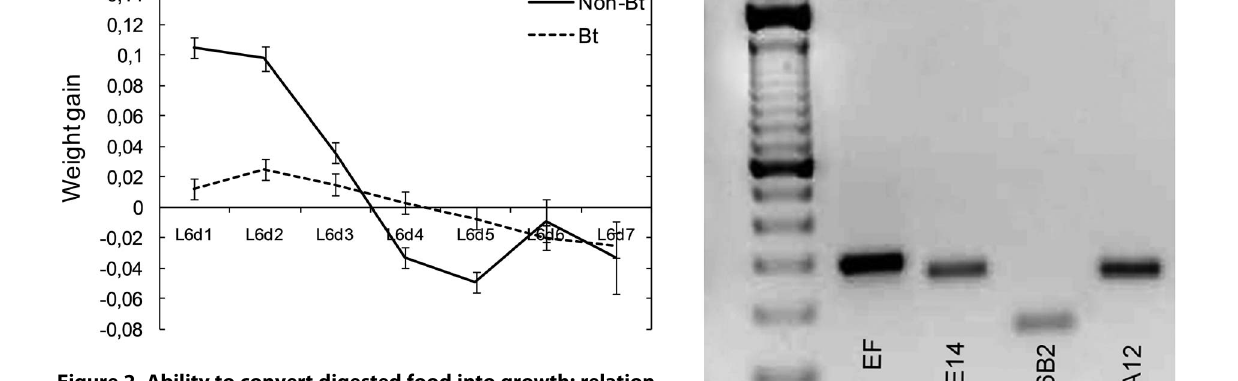
Figure 2. Ability to convert digested food into growth: relation between larval weight gain and the subtraction of weight of frass produced from weight of the food ingested during the last instar of Helicoverpaarmigera larvae fed on a diet with the Bt and non-Bt leaves. Bars show least significant differences (P , 0.05) for each mean in the ANCOVA of weight gain when ‘food intake-faeces’ is the covariate.